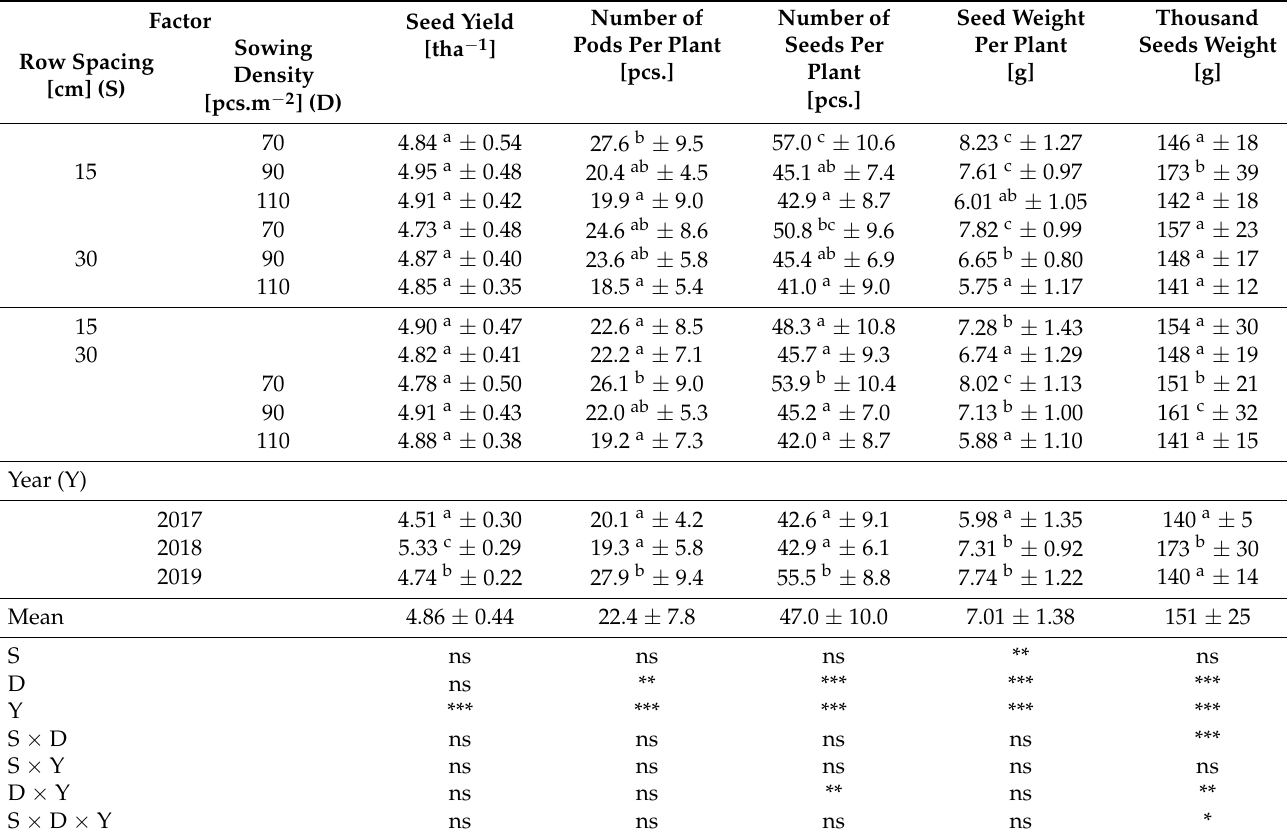
Table 4. Effect of row spacing and sowing density on seed yield and structural yield components of soybean. Factor Seed Yield [g]Row Spacing